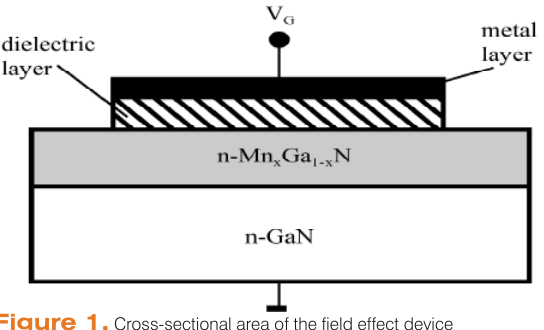
Figure 1. Cross-sectional area of the field effect device